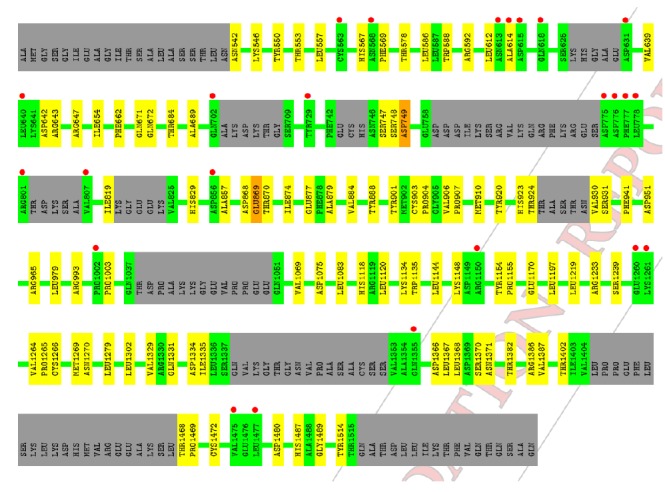
DOI:
http://dx.doi.org/10.7554/eLife.22567.027